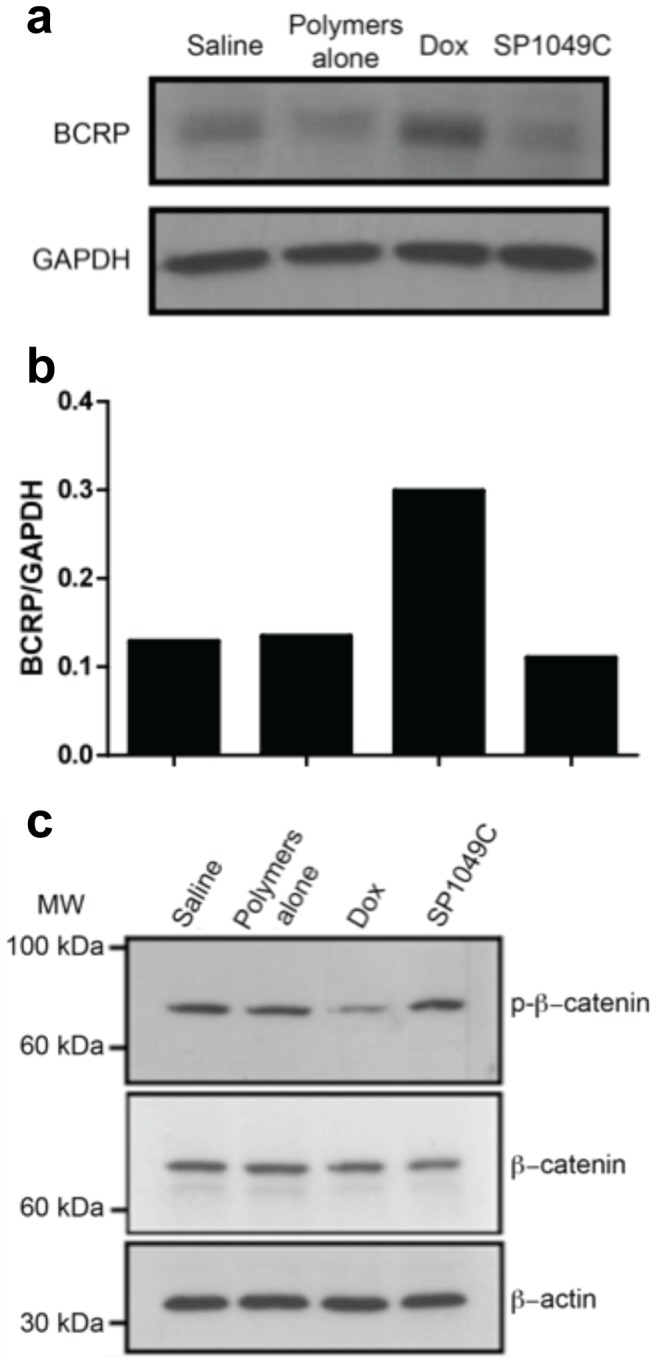
BCRP expression in ascites cells in Passage 6 and Wnt signaling activation in tumor cells from Passage 5.(a) BCRP expression levels, (b) densitometry analysis of BCRP western blot, (c) phospho-β-catenin and β-catenin protein levels. β-actin was used as protein loading control.